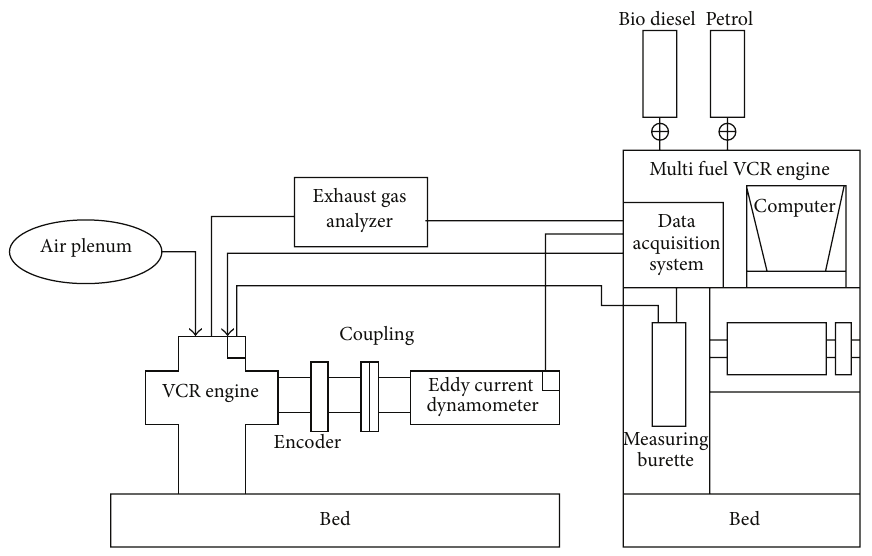
Figure 1: Schematic diagram of the experimental setup.